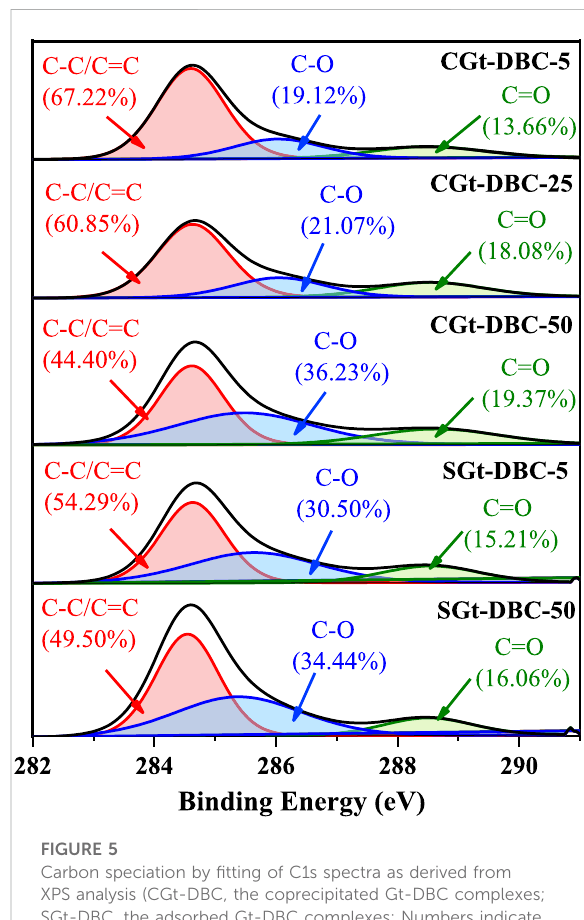
FIGURE 5 Carbon speciation by fi tting of C1s spectra as derived from XPS analysis (CGt-DBC, the coprecipitated Gt-DBC complexes; SGt-DBC, the adsorbed Gt-DBC complexes; Numbers indicate the additive concentration of DBC in the preparation of Gt- DBC